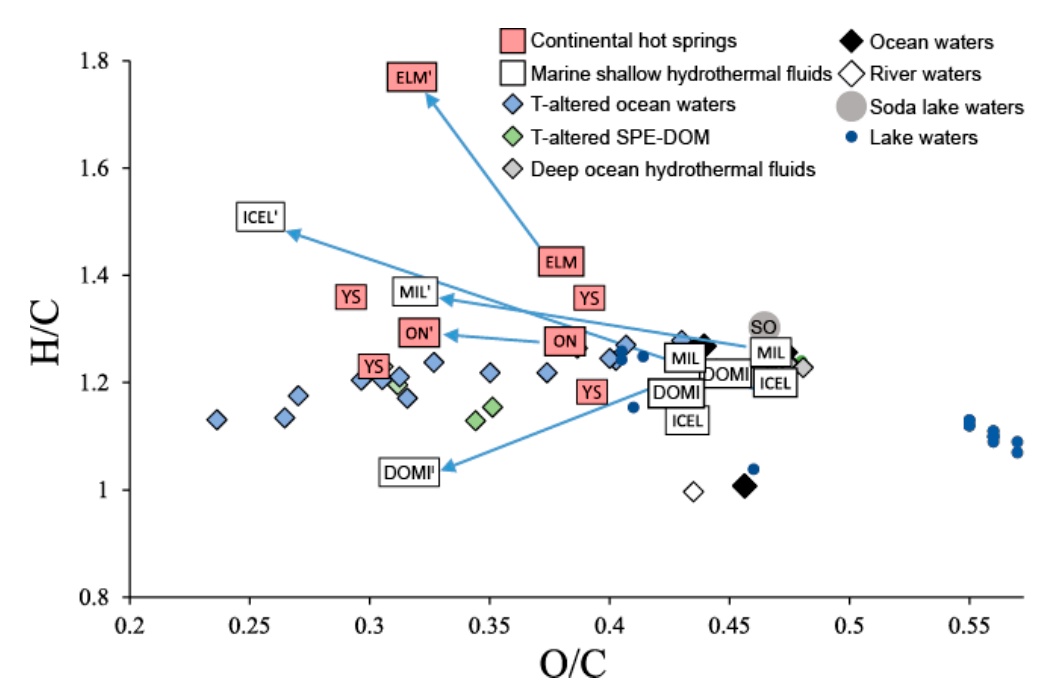
Figure 3. Van Krevelen diagrams showing weighted H / C vs. O / C values (in rectangle) in SPE-DOM samples collected from di ff erent hydrothermal systems or altered by heat experiments. Values from freshwater lakes and ocean waters are provided for comparative purposes. Arrows highlight the di ff erence between the weighted O / C and H / C ratios in SPE-DOM from a sample and the same ratios estimated by considering the molecules detected exclusively in that sample. YS: Yellowstone hot springs [9]; MIL: Milos shallow hydrothermal fluids [9]; DOMI: Dominica shallow hydrothermal fluids [7]; ICEL: Iceland shallow hydrothermal fluids [7]; ELM: Elementaita hot spring; ON: Ol Njorowa hot spring. Symbols refer to data collected from deep ocean [5] and Pacific Ocean waters